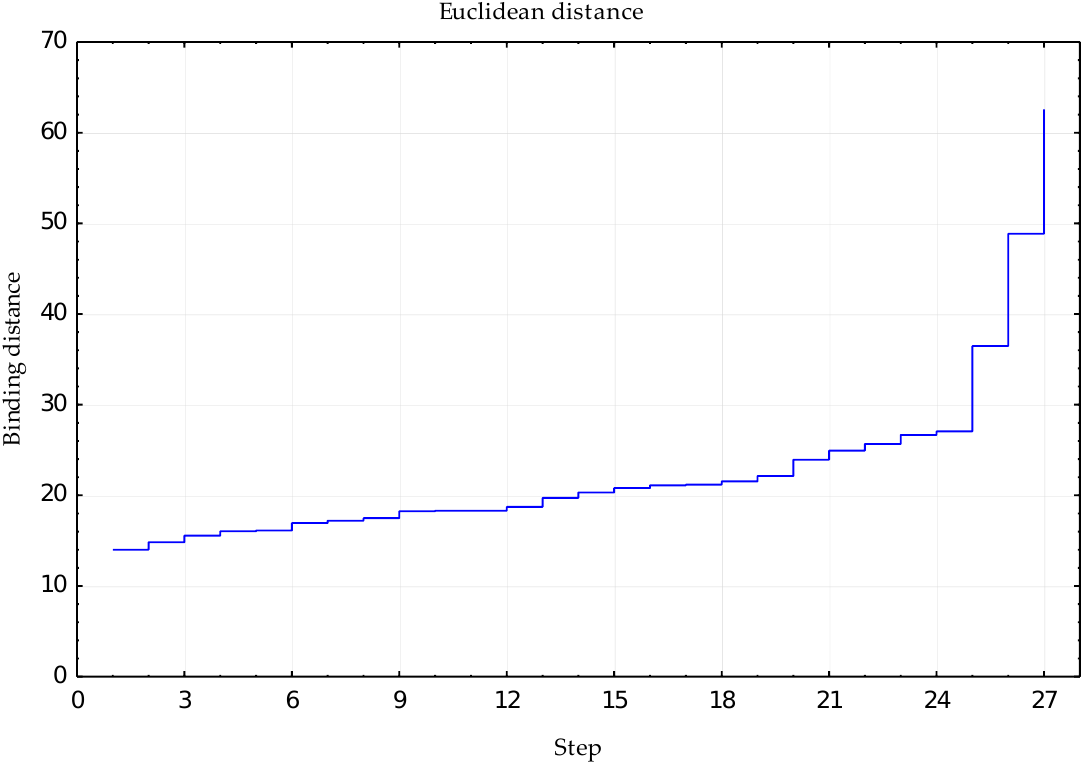
Figure 2. Graph of the binding distance relative to the binding steps. Euclidean distance.